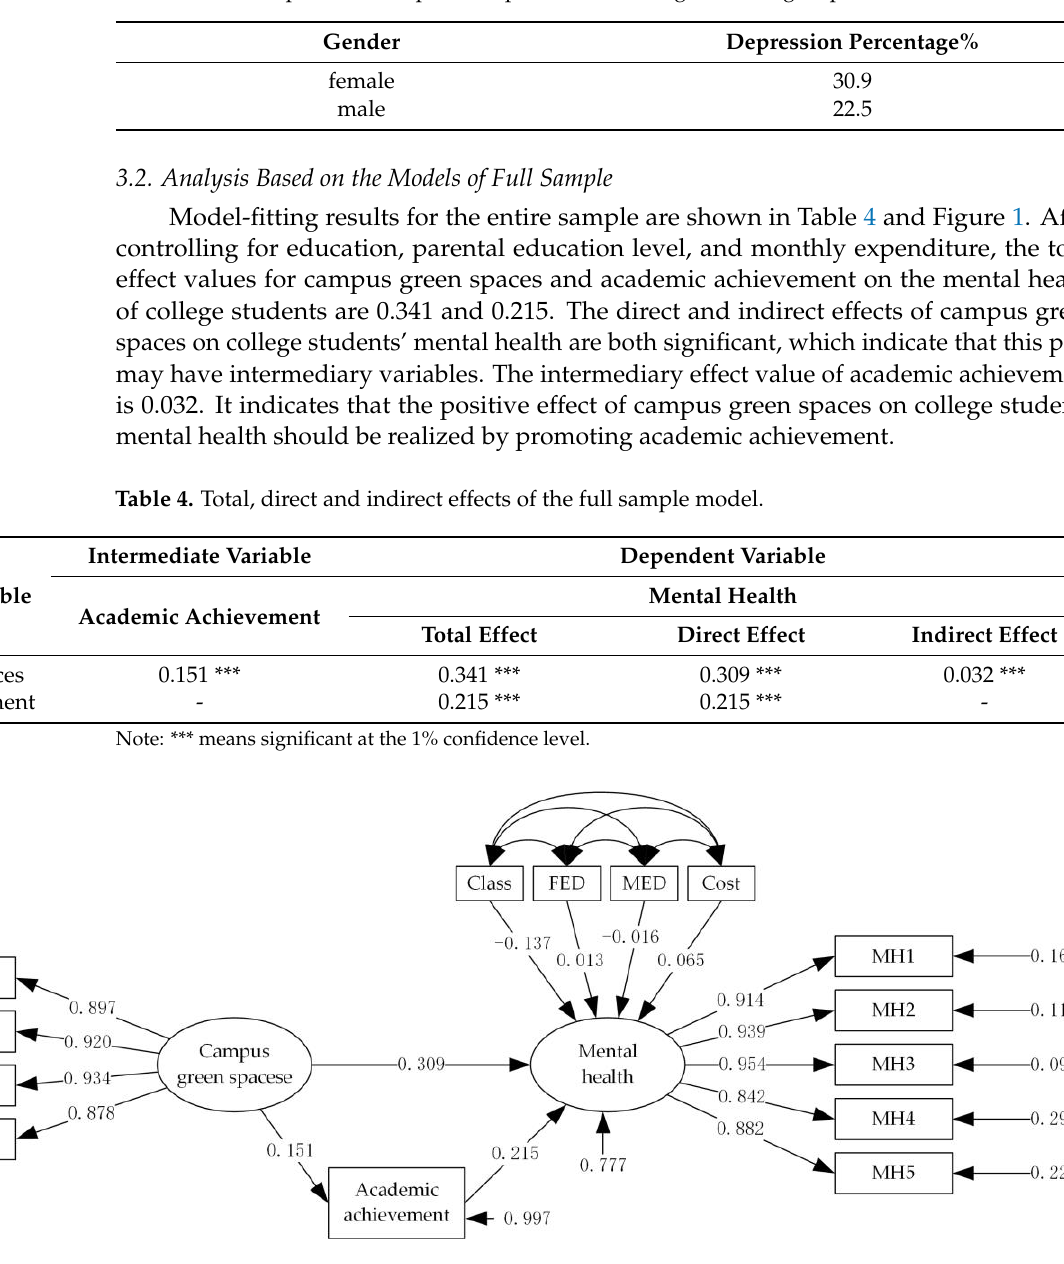
Table 3. The comparison of depression prevalence among different groups.